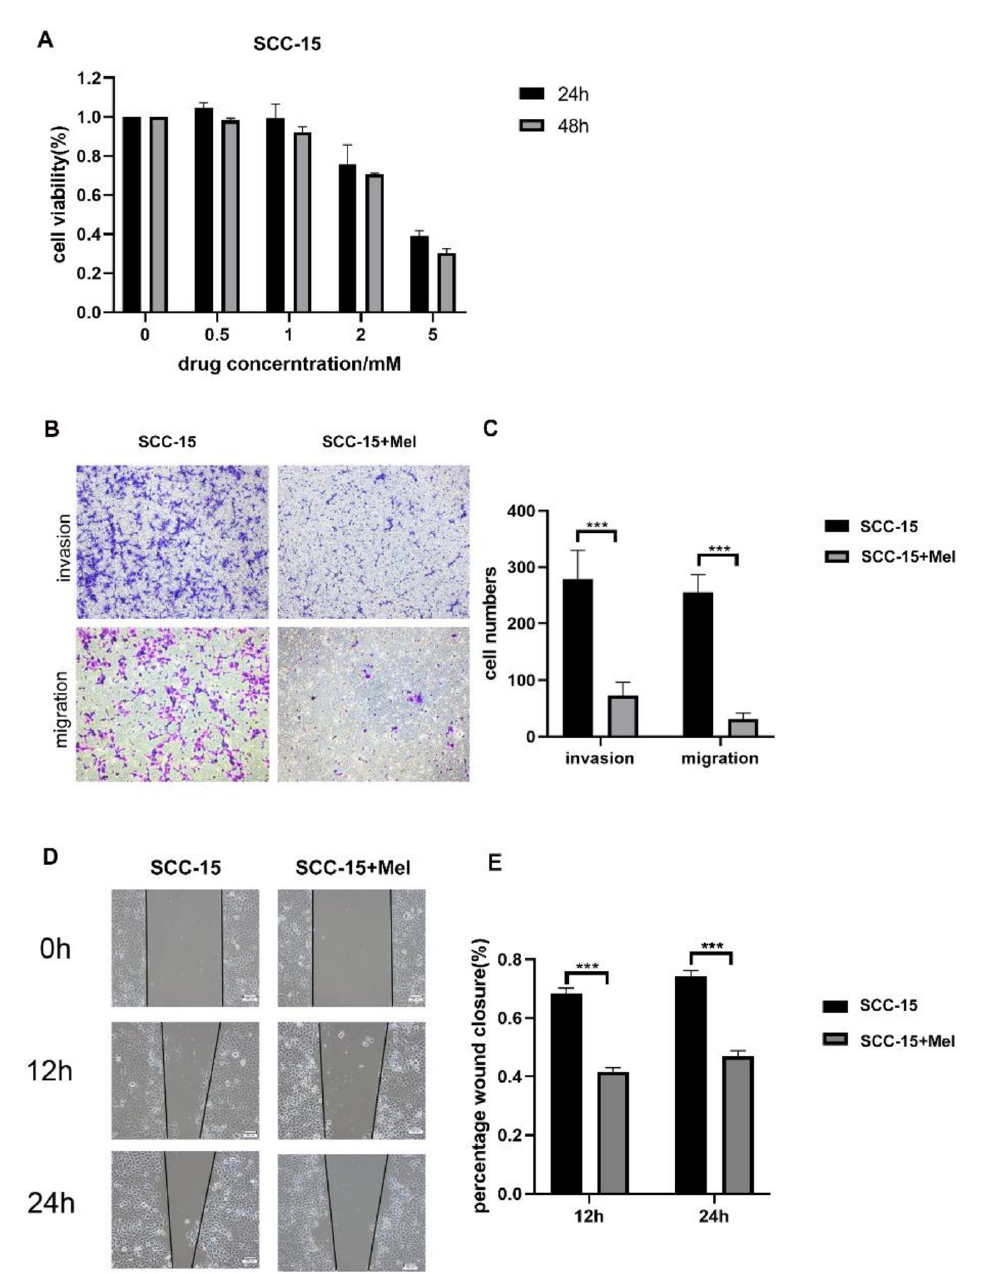
Figure 1. Effects of melatonin (Mel) on SCC-15 cells viability, invasion and migration. SCC-15 cells were treated with different concertation of Mel (0, 0.5, 1, 2, 5 mM) for 24 h and 48 h. ( A ): Cell viability tested by CCK-8. ( B , D ): SCC-15 cells were treated with or without 2 mM melatonin, the invasion and migration ability of cell was determined by trasnwell migration assays at 24 h ( B ), transwell invasion assays at 36 h ( B ) and wound healing at 12 h, 24 h ( D ). ( C , E ): Quantitative data from three independent experiments are shown in the right panels, respectively (*** p < 0.001). Scale bars: ( B , D ), 100